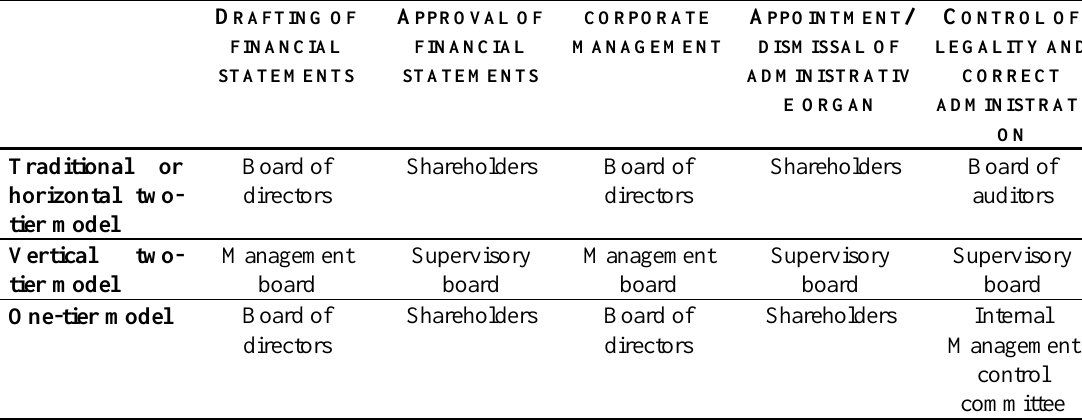
Table 3 : Governance Models and Functions of the Various Governance